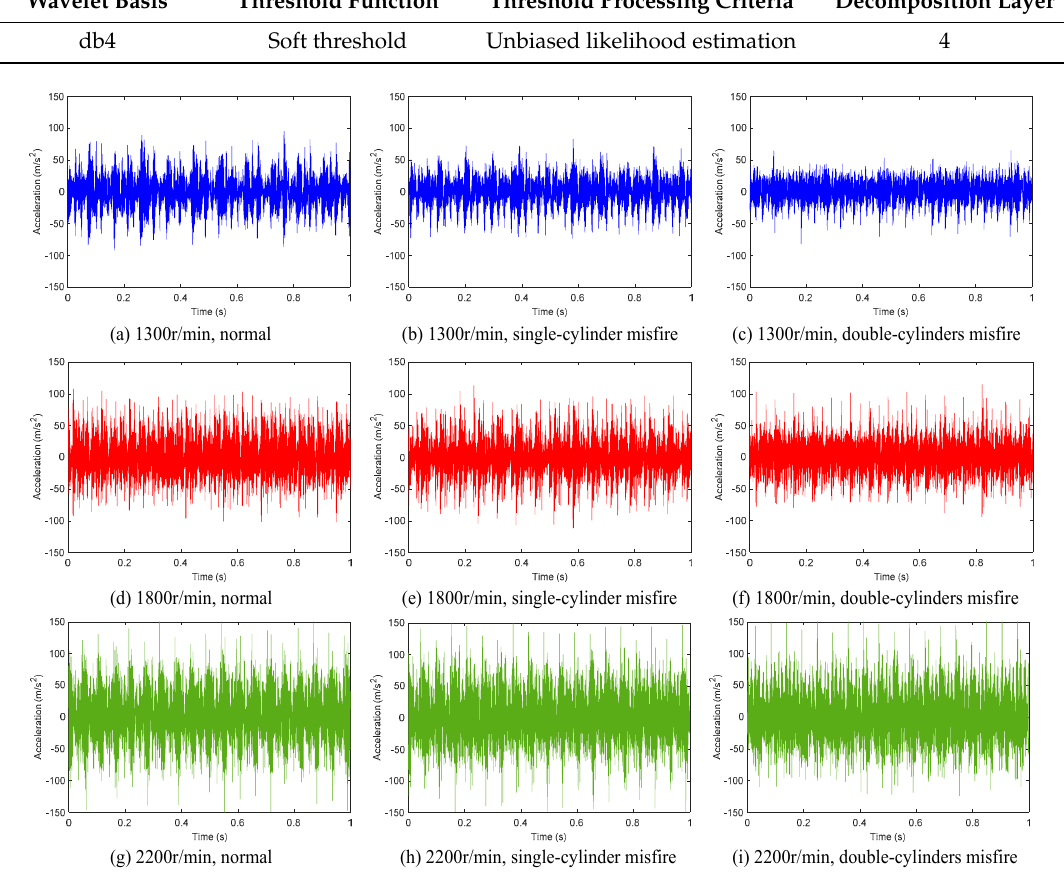
Figure 4. Typical time-domain vibration signal waveforms under different working conditions.